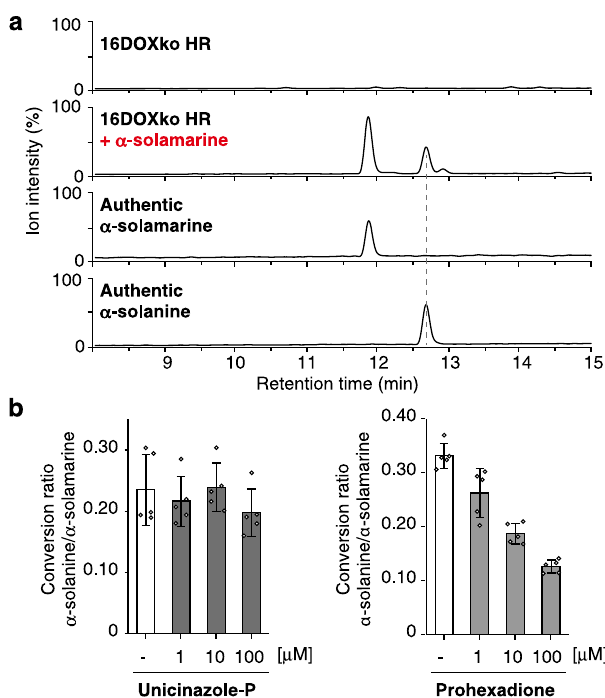
Fig. 2 Bioconversion of the solanidane-skeleton to the spirosolane- skeleton in potato hairy roots. a LC – MS detection of conversion from administered α -solamarine to α -solanine in 16DOX-disrupted potato hairy roots (16DOXko HR). Total ion current (TIC) chromatogram obtained in positive ionization mode with a full-scan range of 350 – 1250 m/z are shown. Production of α -solanine was con fi rmed by comparison with the authentic standard of α -solanine in terms of retention time and mass spectrum provided in Supplementary Fig. 1. b Inhibition of the bioconversion of α - solamarine to α -solanine by uniconazole-P or prohexadione. After administering α -solamarine for 3 days in the presence of uniconazole-P or prohexadione, the SGAs accumulated in 16DOXko HR were extracted and quanti fi ed using LC – MS. Bars represent the ratio of α -solamarine to α - solanine accumulation in hairy roots. Error bars represent ± standard deviation of mean ( n =